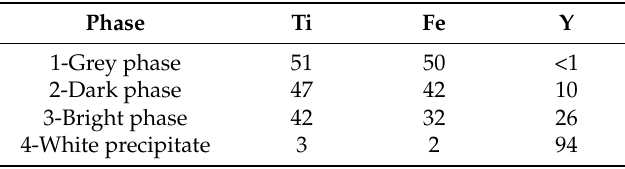
Table 3. Measured atomic abundance of the various phases presents in the TiFe alloy + 6 wt.% Y. All values are in at.%. The error on each value is ±1%.